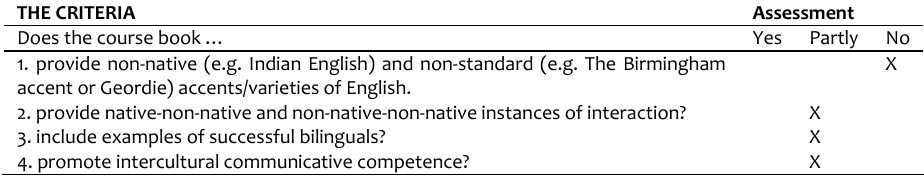
Table 2 . The Results of ReLearn with regard to the sociolinguistic textbook evaluation checklist THE